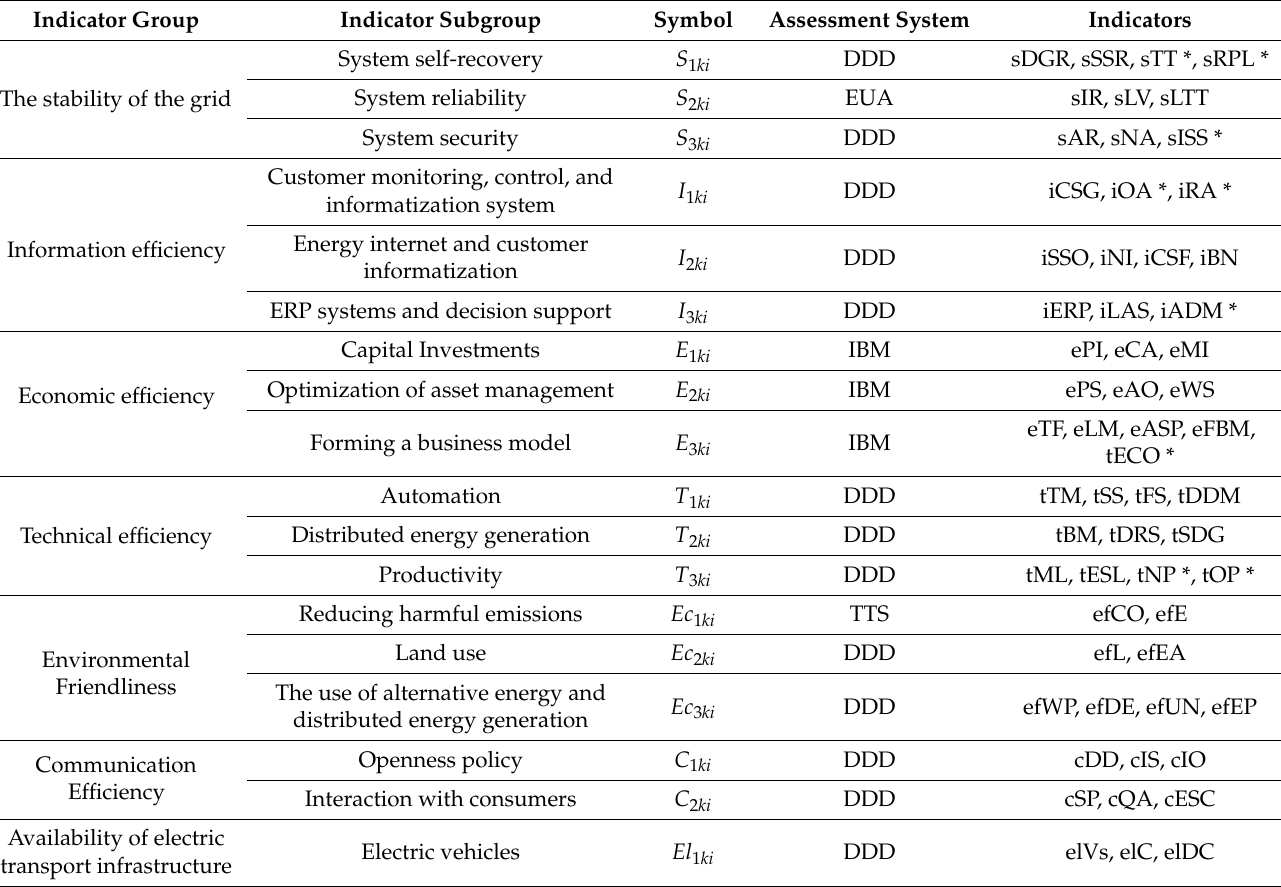
Table 1. Basic comprehensive assessment systems and final indicators for assessing smart grids’